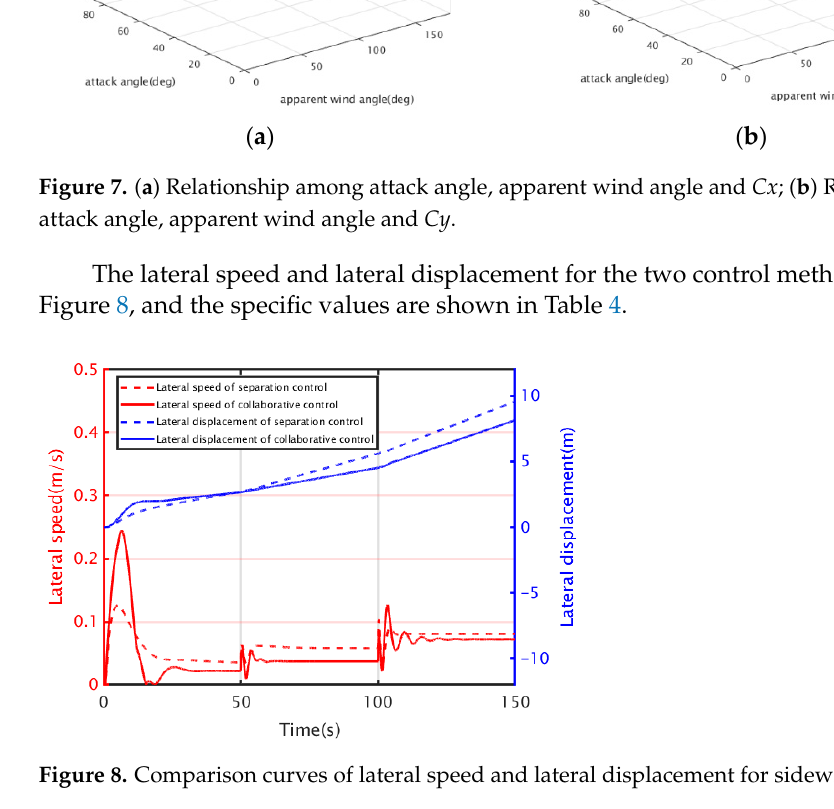
Figure 8. Comparison curves of lateral speed and lateral displacement for sidewind sailing.